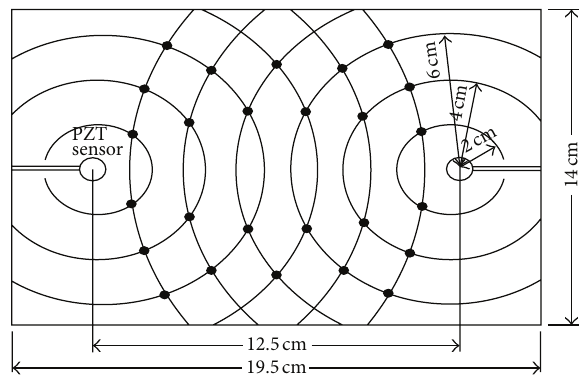
Figure 11: Schematic of impact points in the composite plate with two